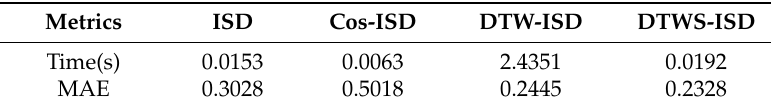
Table 1. Comparison of four proposed